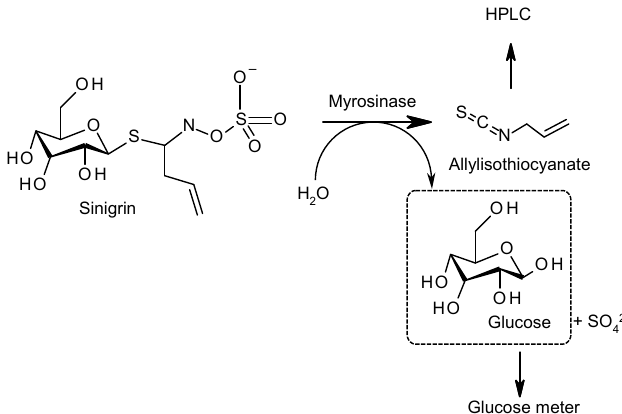
Fig. 1: Rapid assay (‘ITC quick test’) for estimating the glucosinolate content of horseradish. Exogenous myrosinase is added to allow for the complete degradation of endogenous glucosinolates. Equimolar amounts of glucose, sulfate and isothiocyanate are released. Glucose is determined using a commercial glucose strip/meter